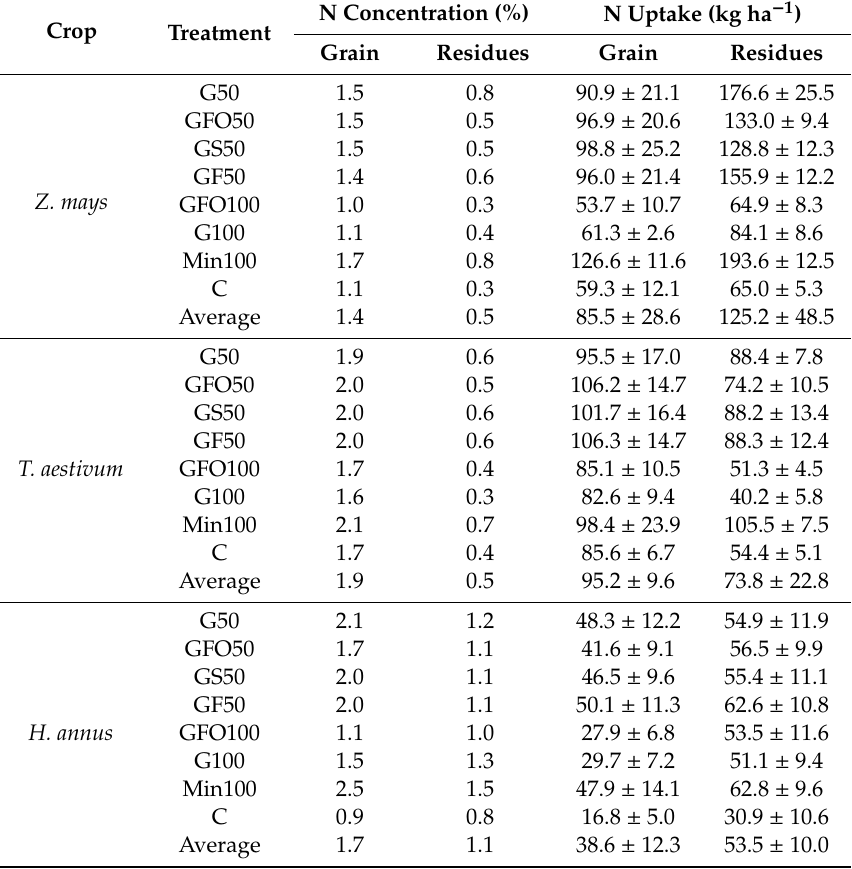
Table 5. Nitrogen (N) concentration (%) in the grain and residues of the studied crops. Crop